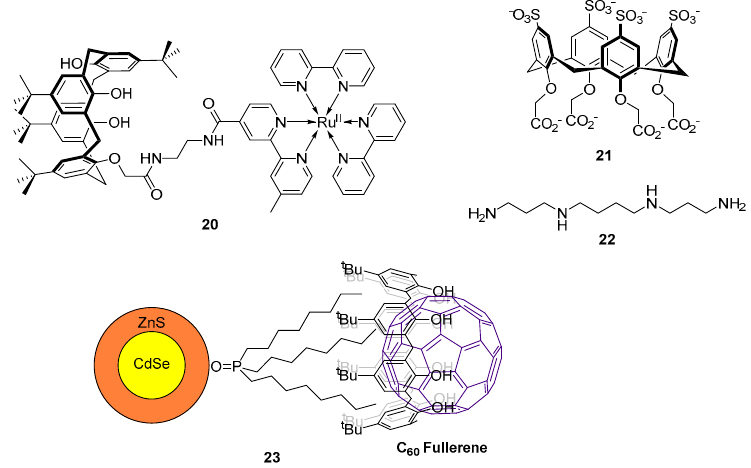
Figure 10. Ruthenium(II)-bipyridine-substituted calix[4]arene sensor 20 is a turn-off probe for CN − , which causes fluorescence quenching and a blue-shift of the emission band at 624 nm [93]. The simple, polyanionic calix[4]arene-based sensor 21 is an ‘on-off’ probe for spermine 22 [94], while a QD-appended calix[8]arene receptor forms the complex 23 with C 60 fullerene, which quenches the QD fluorescence output [95].